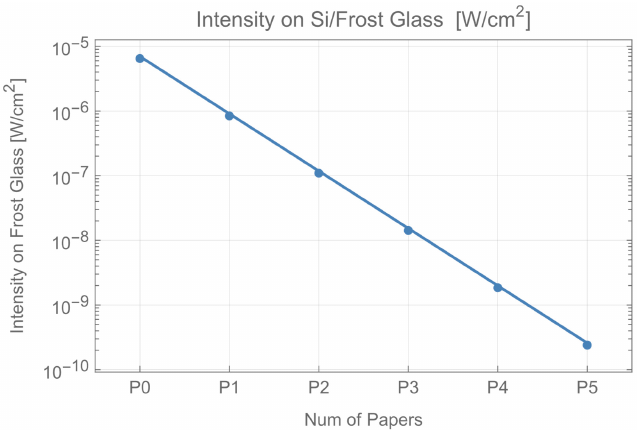
Figure 6. Intensity on Si/frost